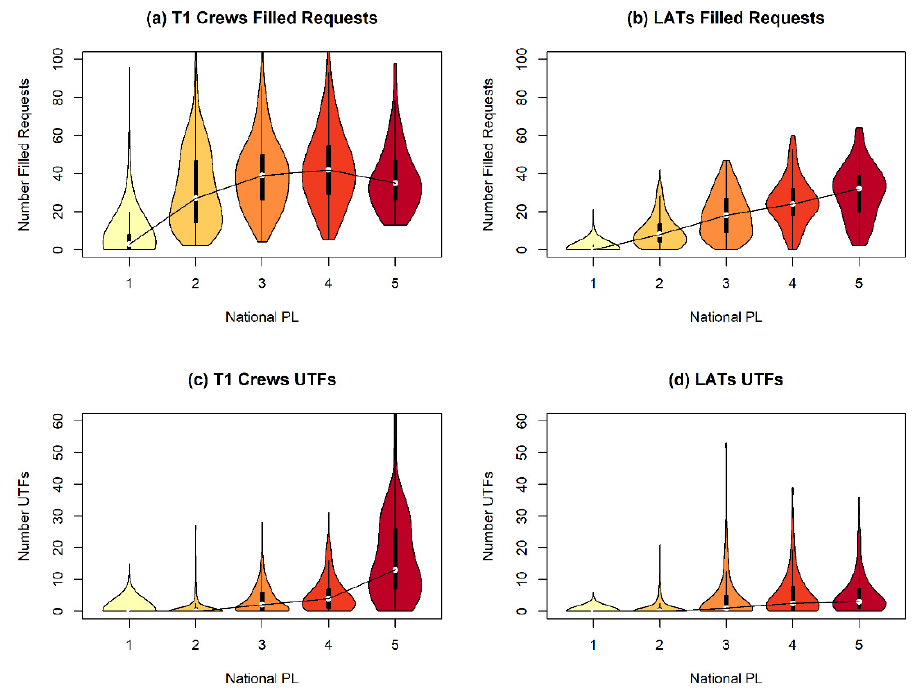
Figure 8. Violin plots showing the total number of filled requests daily by Preparedness Level (PL) for all days from 2014 to 2018 for ( a ) T1 crews and ( b ) large airtankers (LATs). In addition, violin plots showing the total number of requests returned UTF daily by PL for all days from 2014 to 2018 for ( c ) T1 crews and ( d ) LATs.